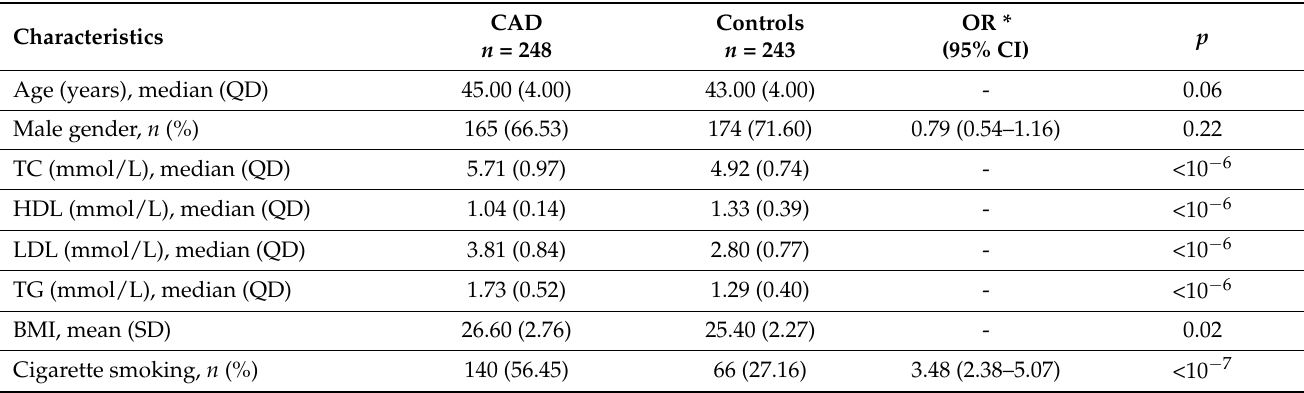
Table 1. Clinical and biochemical characteristics of coronary artery disease (CAD) patients and controls.